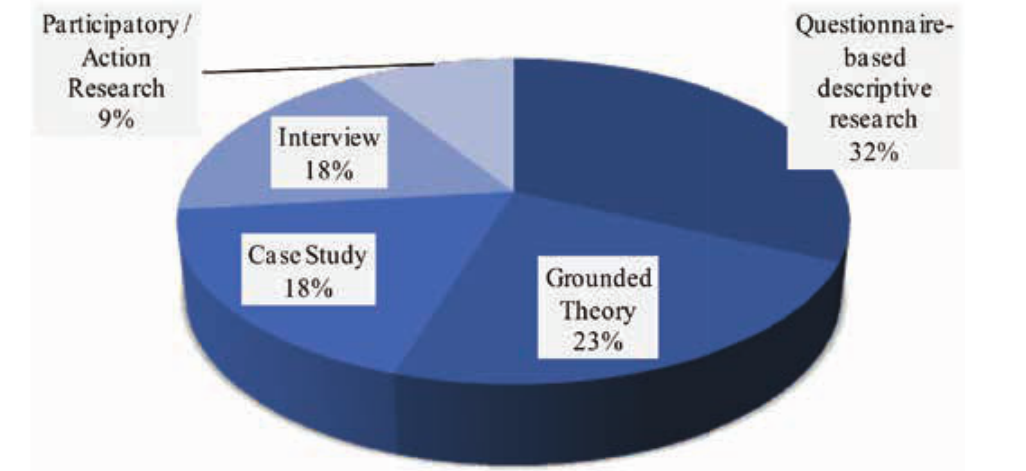
Figure 2. Research Methods Used in Management Research – Karami et al (2006) Out of 217 articles published in the leading management journals, a total of 32% (69) were questionnaire-based descriptive research, 23% (50) used the grounded theory approach, 18% (40) employed the case study method, 18% (38) conducted interviews and 09% (20) were based on action research. In the case of knowledge management research, out of 630 articles published during 2006 and 2008 in the most recognized knowledge management journals, 28% (175) used no identifiable research methodology while 72% (455) used provisionally identifiable research methods (see Figure 2). As shown in the breakdown of the